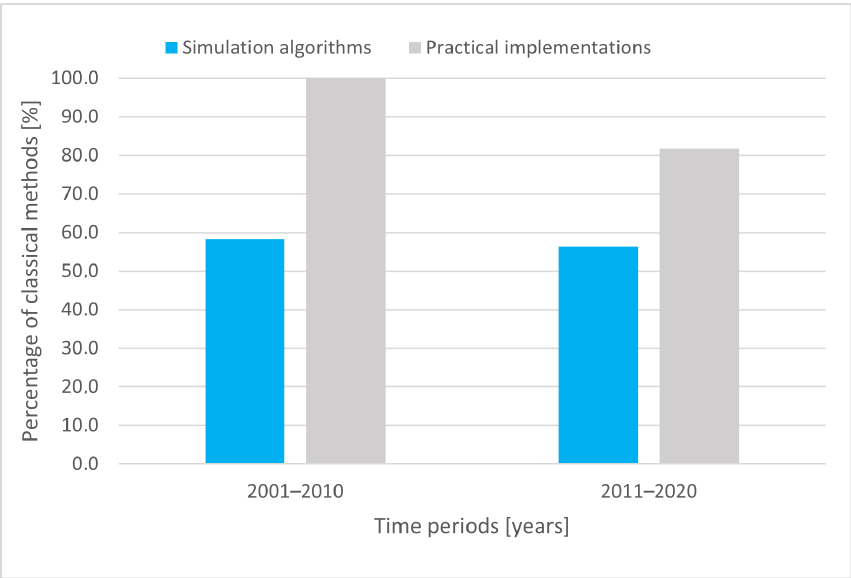
Figure 5. Percentage of classical methods used in simulations studies and real applications in the last 20